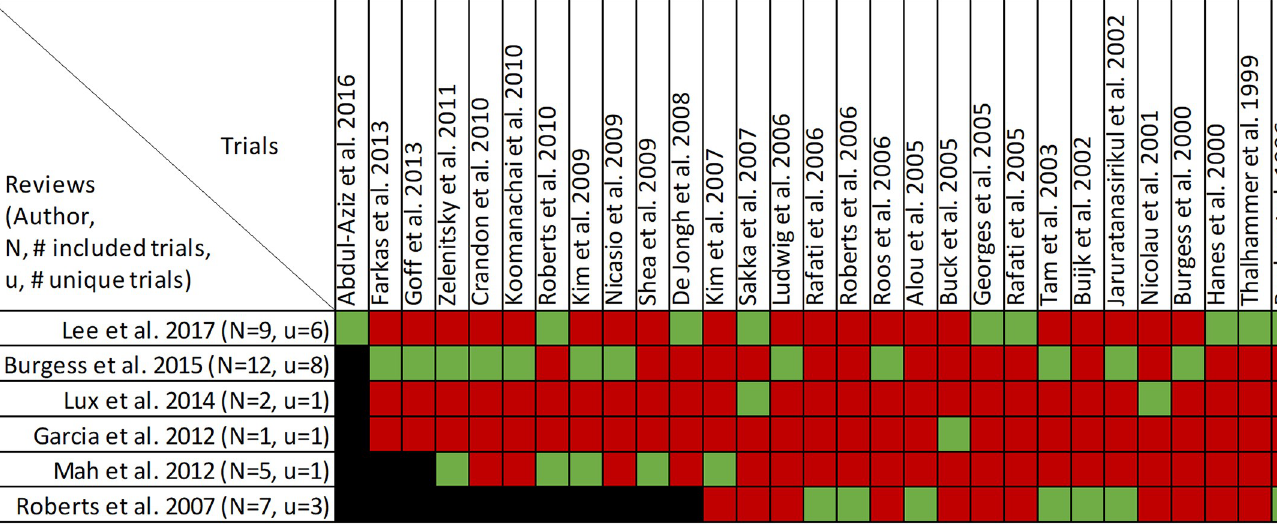
Fig 20. Citation matrix for reviews reporting PK/PD outcomes of prolonged versus intermittent infusions of beta-lactams. Green—primary studies included in systematic review, Red—primary study not included in systematic review, Black—primary studies published after systematic review and therefore ineligible for possible